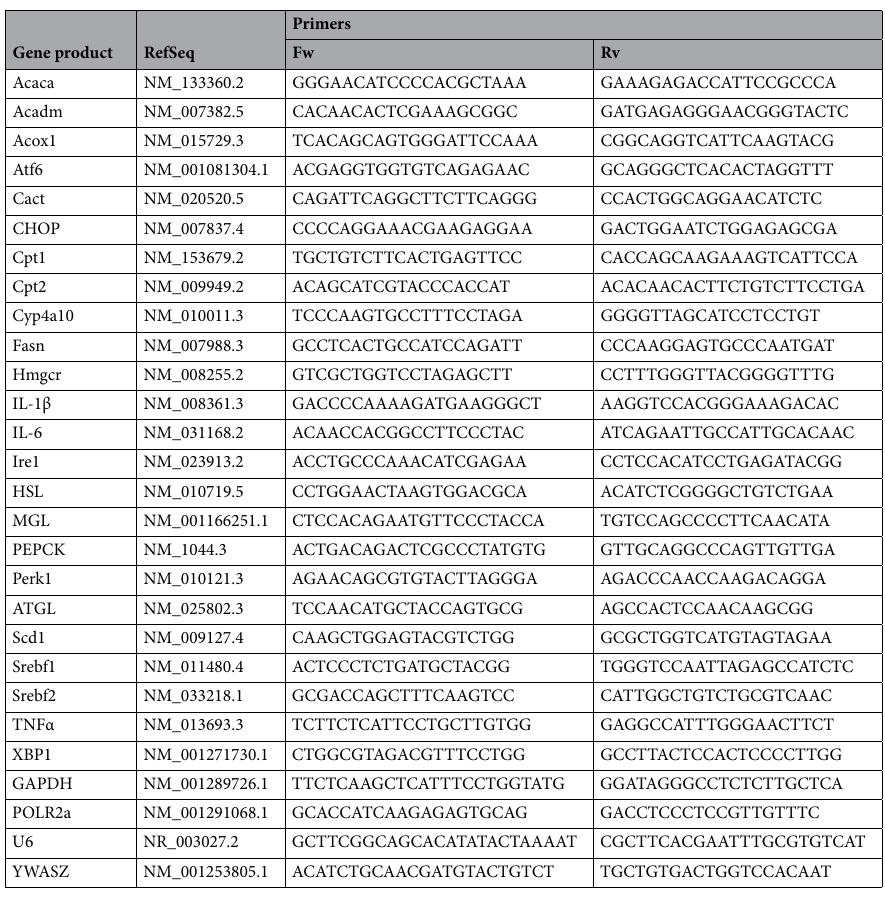
Table 1. Primers sequences used for SYBR Green